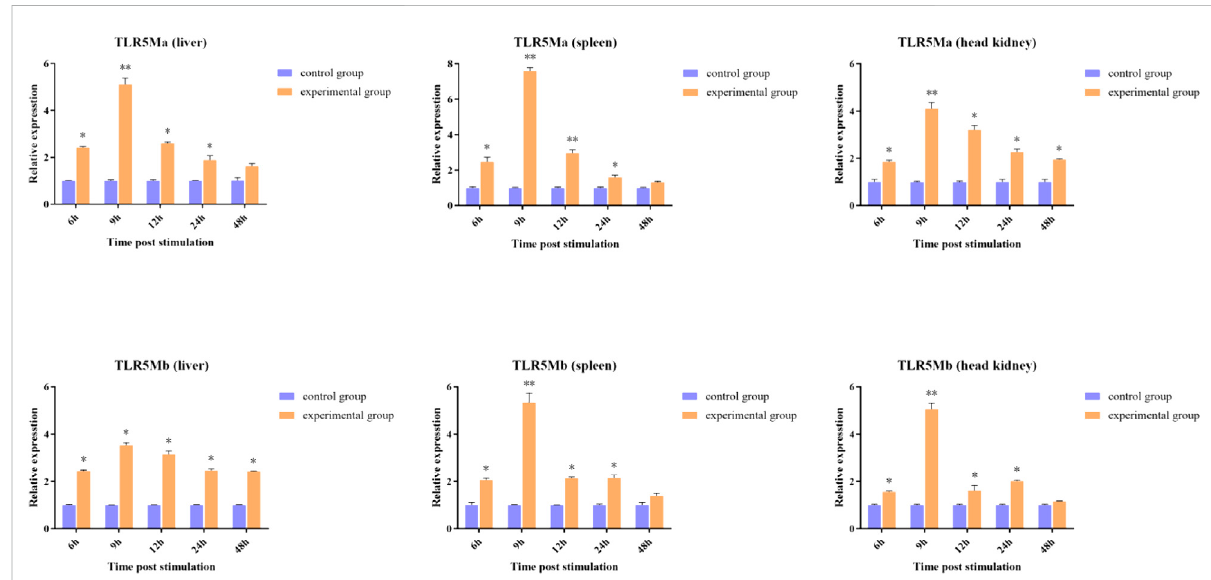
FIGURE 4 The expression patterns of CiTLR5Ma and CiTLR5Mb on transcription level in tissues of liver, spleen and head kidney, after infected with A. hydrophila . The expression level of CiTLR5Ma and CiTLR5Mb on 0 h was used as the baseline calibrator. The signi fi cance levels were obtained by comparing with corresponding 0 h (* p < 0.05, ** p < 0.01).